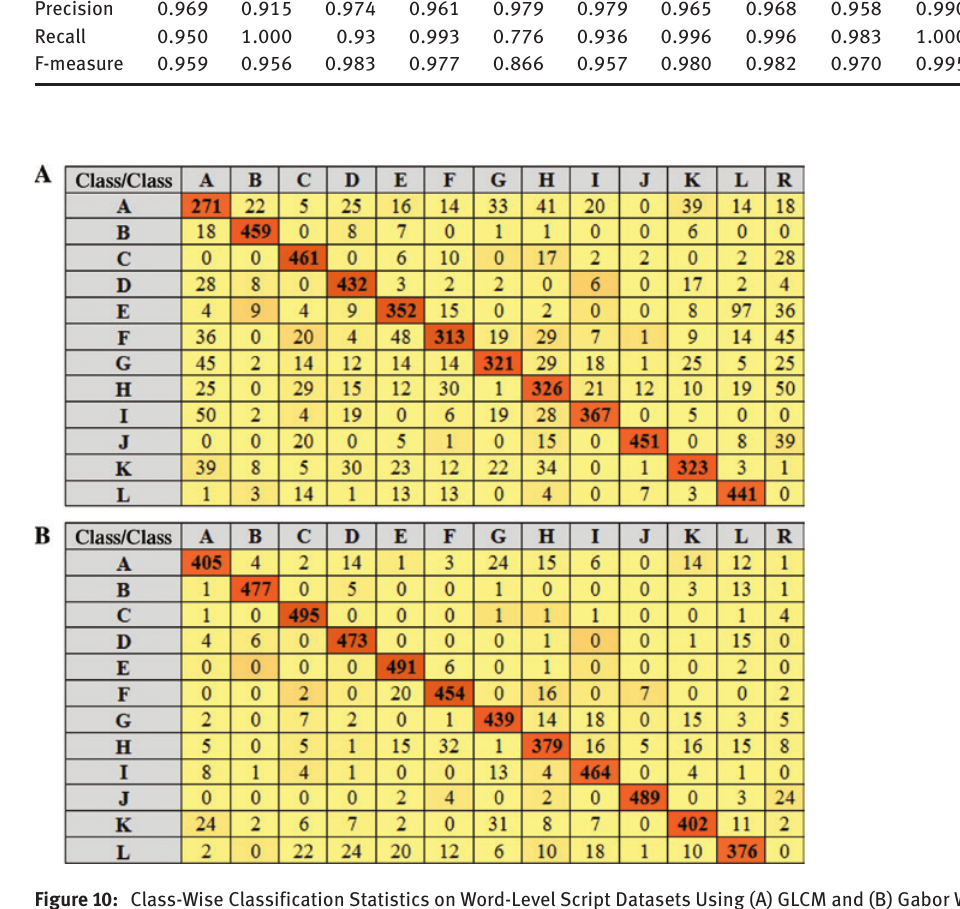
Figure 10: Class-Wise Classification Statistics on Word-Level Script Datasets Using (A) GLCM and (B) Gabor Wavelet Transform.